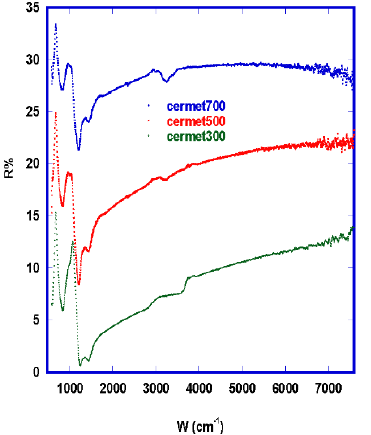
Figure 10. Comparison of FTIR reflectance of cermet samples.